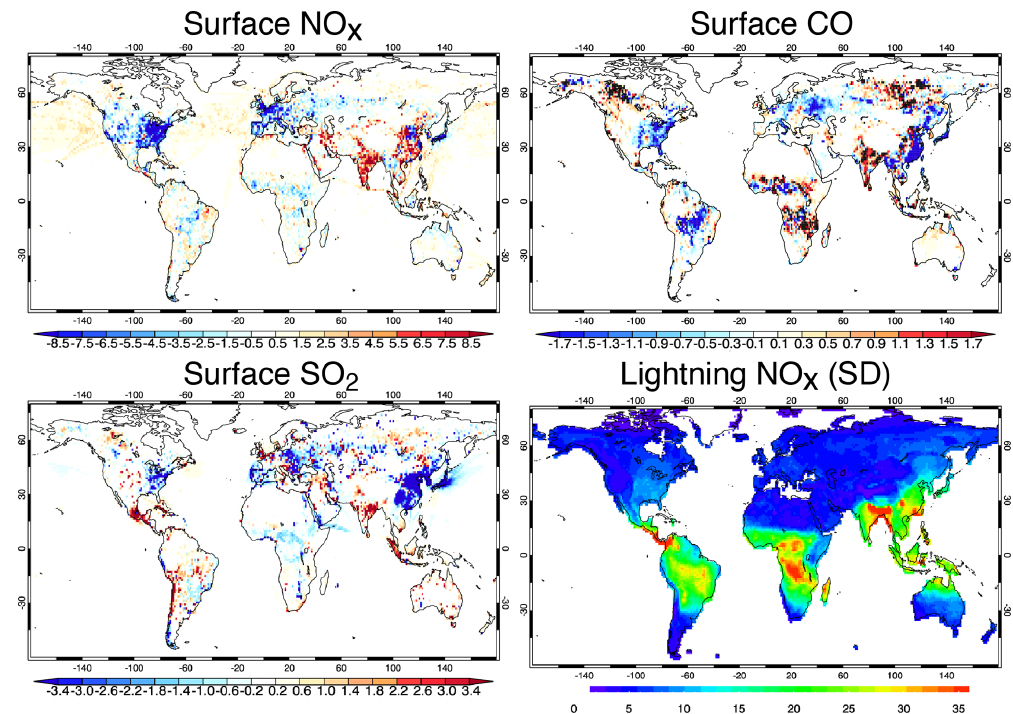
Figure 14. Global distribution of linear trend of the a posteriori surface NO x emissions (in 10 − 13 kgNm − 2 s − 1 per year), surface CO emissions (in 10 − 11 kgCOm − 2 s − 1 per year), and surface SO 2 emissions (in 10 − 14 kgSm − 2 s − 1 per year), and standard deviation of the a posteriori lightning NO x emissions (in 10 − 14 kgNm − 2 s − 1 per year) for the period 2005–2018. The red (blue) color indicates positive (negative) trends.